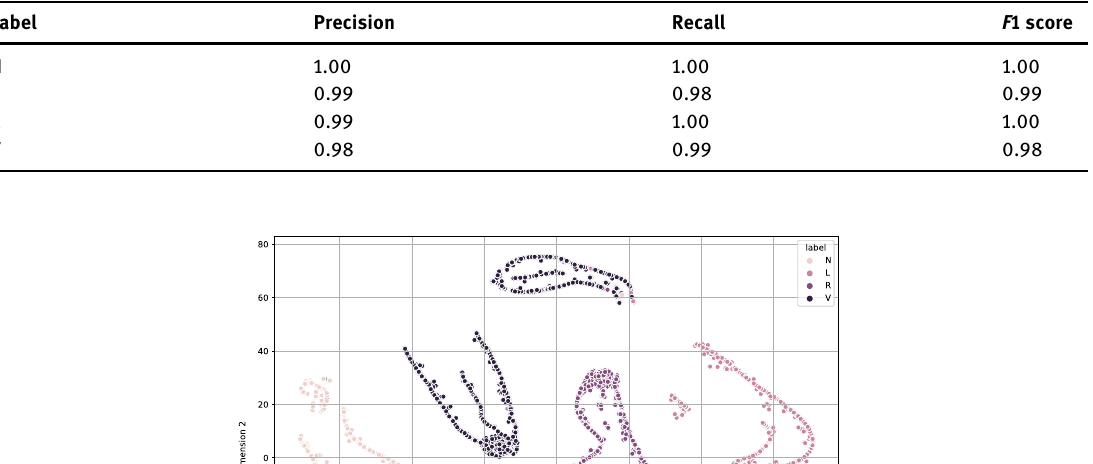
Table 3: Results obtained for the testing set Label